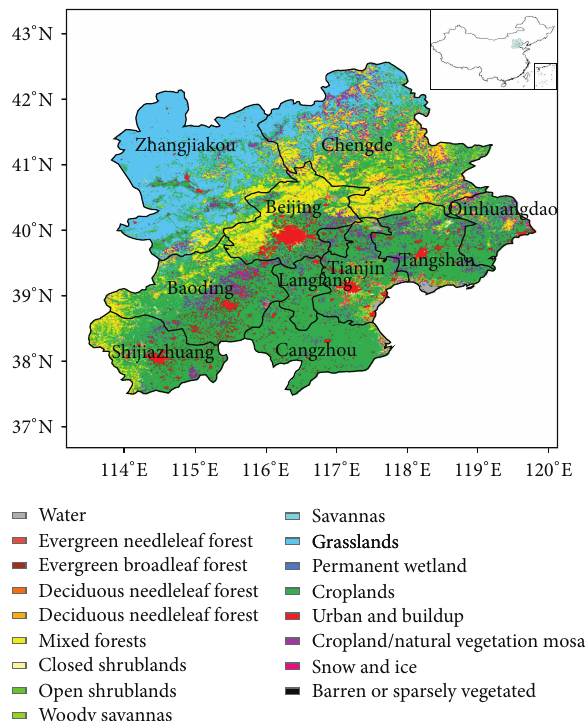
Figure 1: Study area and land cover types based on MODIS land cover